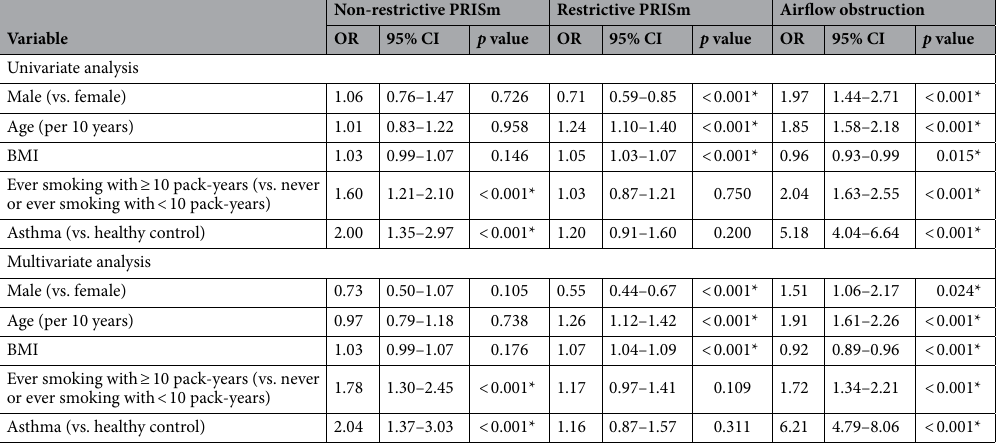
Table 2. Univariate and multivariate logistic analyses investigating the risk factors of non-restrictive PRISm, restrictive PRISm and airflow obstruction. BMI body mass index; CI confidence interval; OR odds ratio; PRISm preserved ratio impaired spirometry. * P < 0.05 logistic regression analysis.